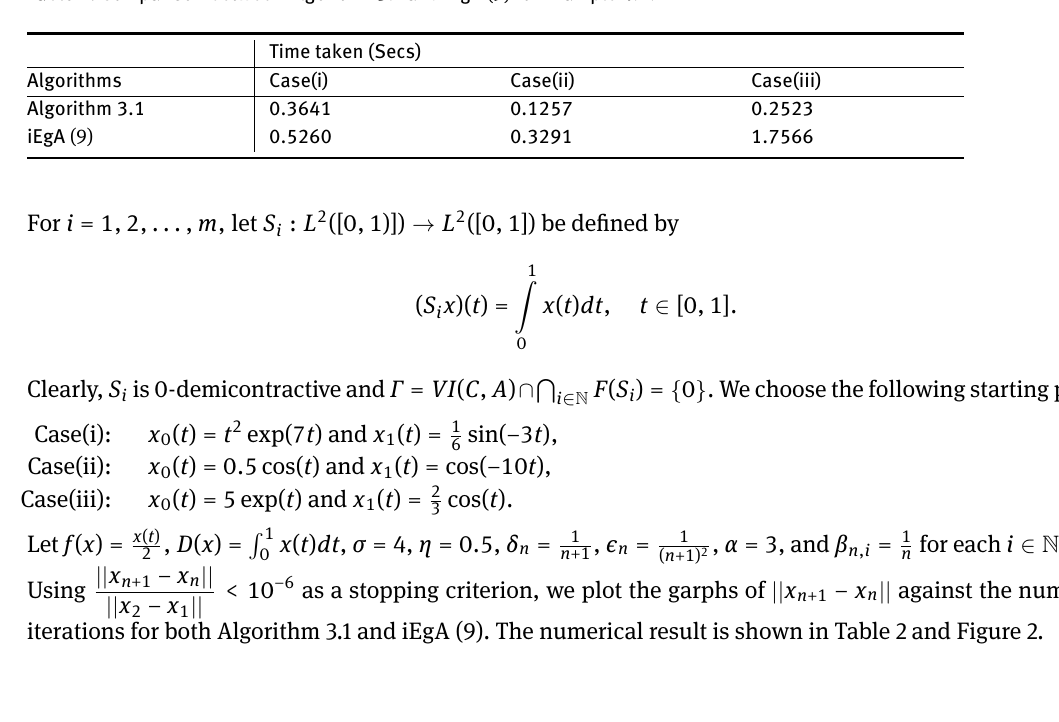
Figure 1: Example 4.1, Top-Left: Case(i); Top-Right: Case(ii); Bottom: Case(iii).